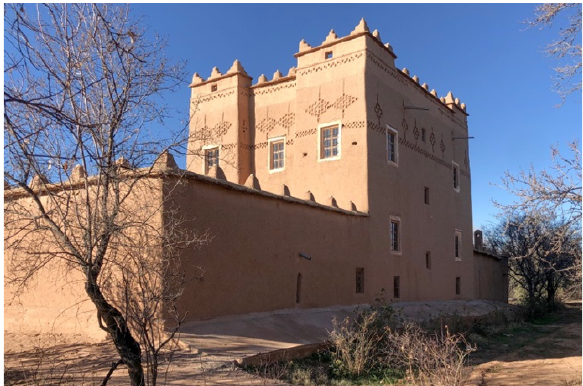
Figure 8. “Kasbah Aït Moussa”, Kelaat